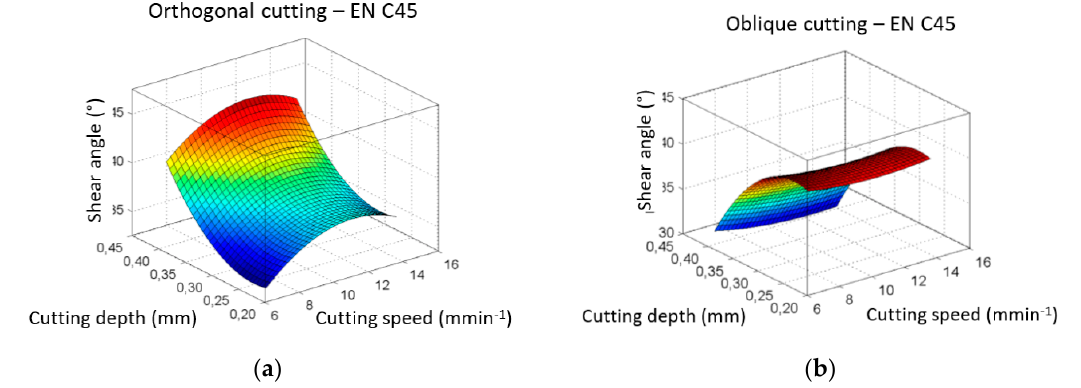
Figure 12. The dependence of shear angle Φ on cutting speed v c and on cutting depth a p ; ( a ) orthogonal cutting; ( b ) oblique cutting.